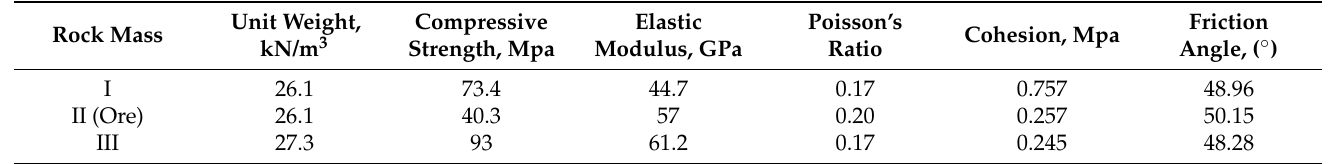
Table 1. Mechanical properties of rock mass used in this analysis